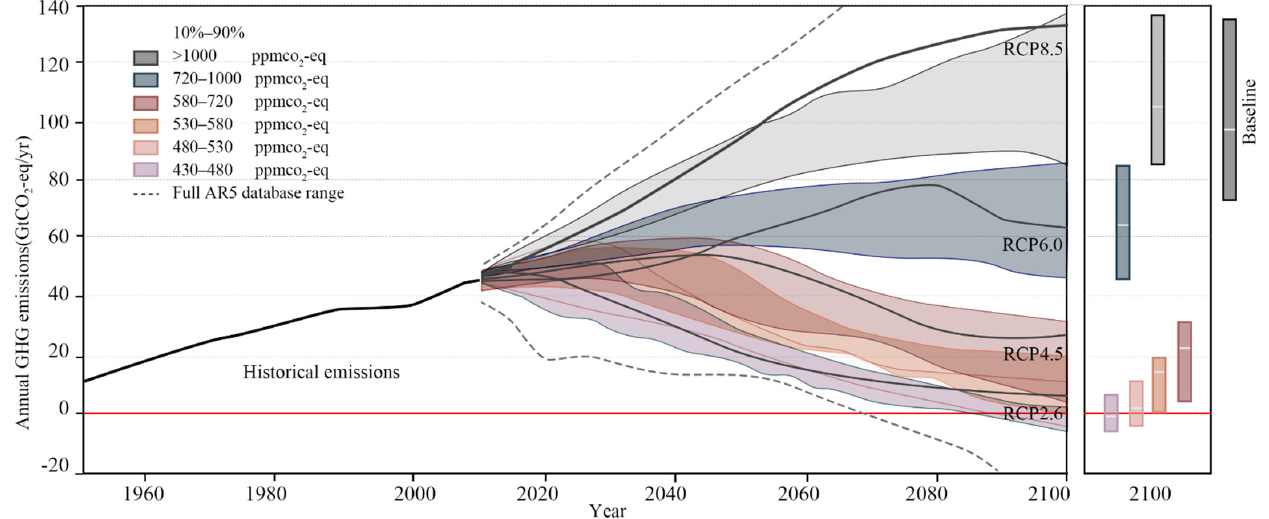
Figure 1. Global greenhouse gas emissions (gigatonne of CO 2 -equivalent per year, GtCO 2 -eq/yr) in baseline and mitigation scenarios for different long-term concentration levels (data source: Assess- ment Report 5 [2]).